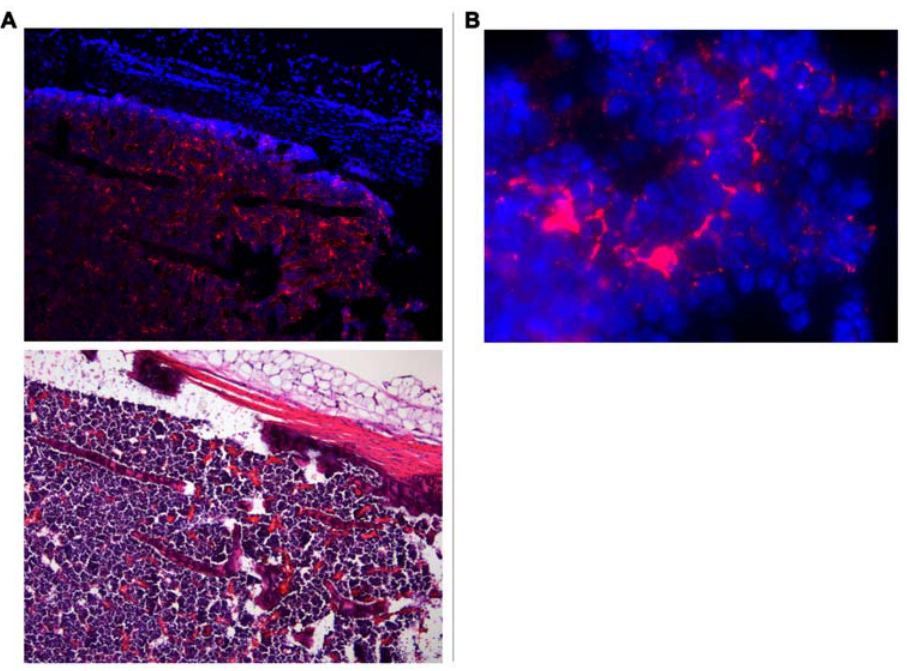
Figure 5. Bone marrow contains IL-7-producing cells. A. A section of femur shows that ECFP (counterstained red) is produced in bone marrow by stromal cells concentrated around vessels. The lower panel shows H&E staining of the same section. Magnification 100 6 . B. As also seen in thymus, bone marrow IL-7 producing cells expressed long dendrites that make extensive contacts with hematopoietic cells. Magnification 1000 6 .